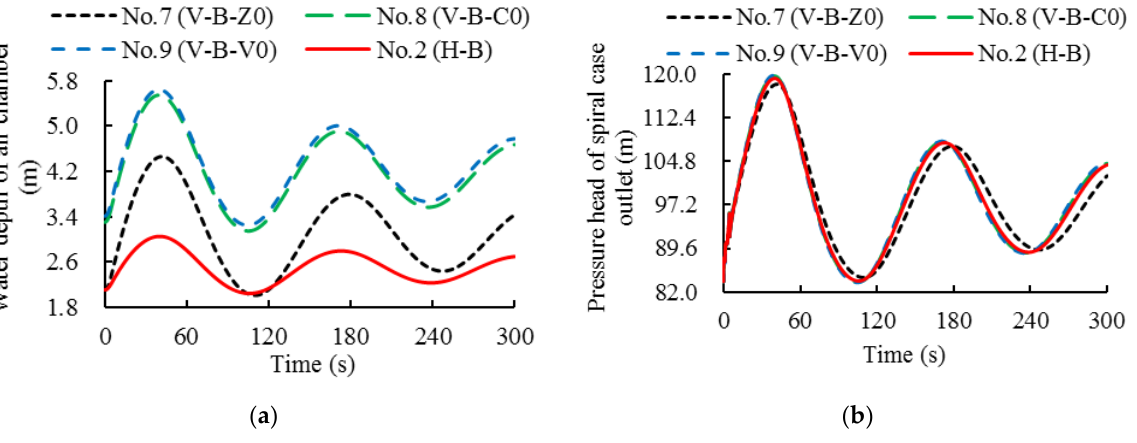
Figure 4. Comparison of horizontal and vertical ACSCs under load rejection condition B: ( a ) Water depth varying with time; ( b ) Pressure at the end of spiral case varying with time. with the same 𝑍 0 , the minimum water depth of the vertical ACSC was below the bottom.